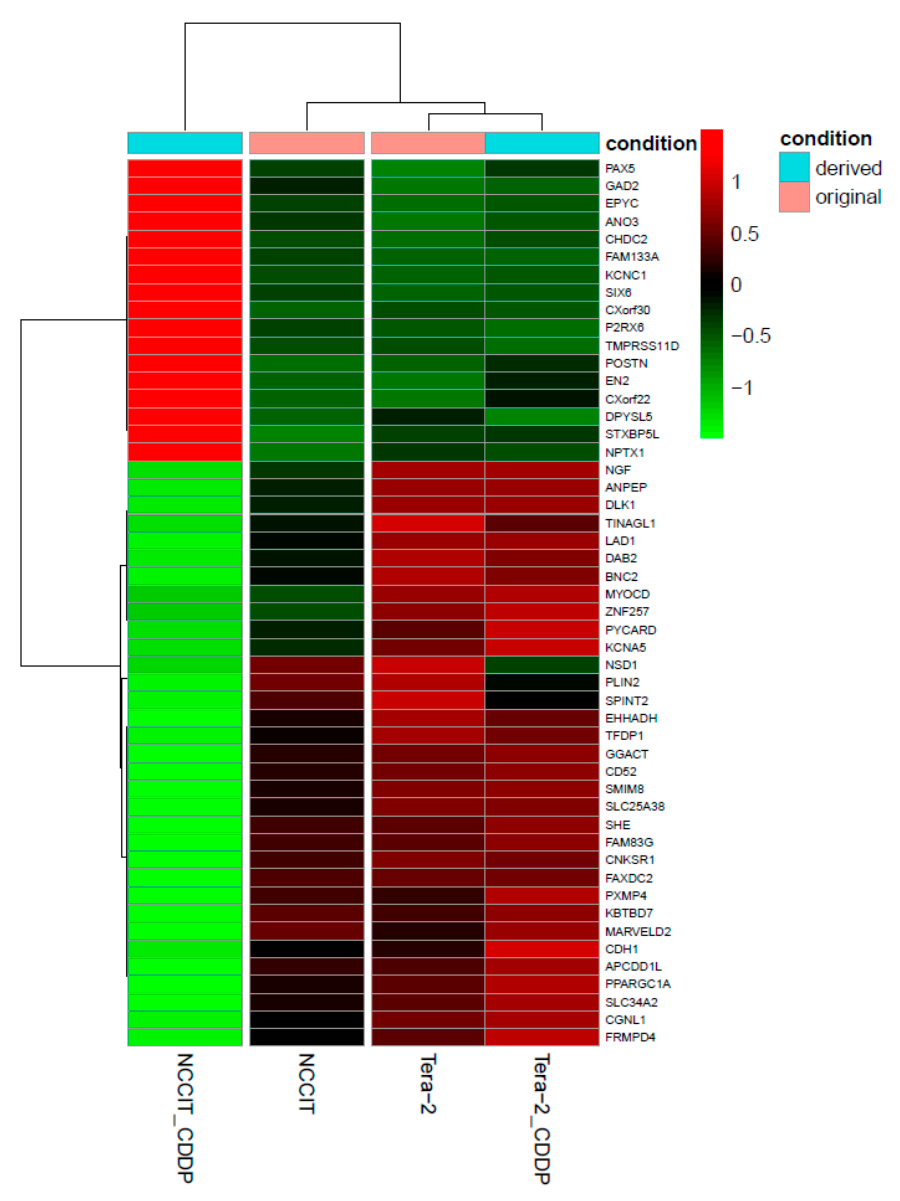
Figure 3. Hierarchical clustering of original and CDDP-treated cell lines based on gene expression profiles of the top 50 differentially expressed genes.